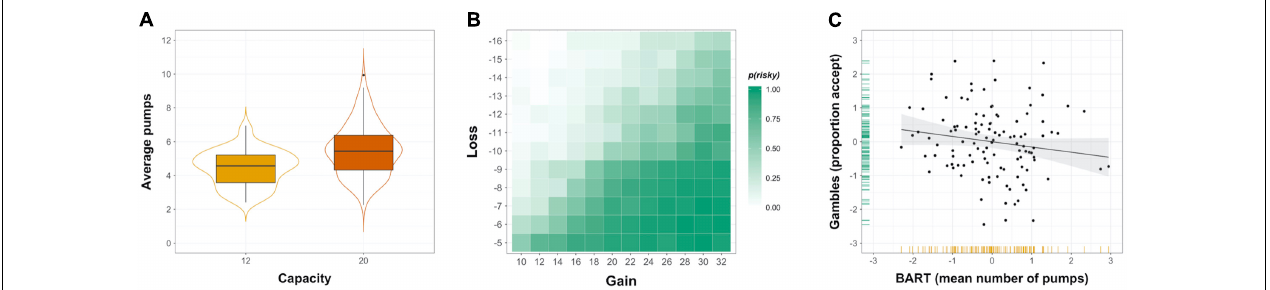
FIGURE 2 | Risk taking in two common behavioral measures. (A) Distribution of individuals’ average number of pumps in the Balloon Analog Risk Task (BART), shown separately for balloons with capacity 12 and 20. (B) Payoff matrix overlaid with heatmap showing the observed probability of gamble acceptance in monetary gambles. (C) Association between risk taking in the BART and monetary gambles (plotted are the standardized residuals after regressing out effects of age and gender), with variable distributions shown in the